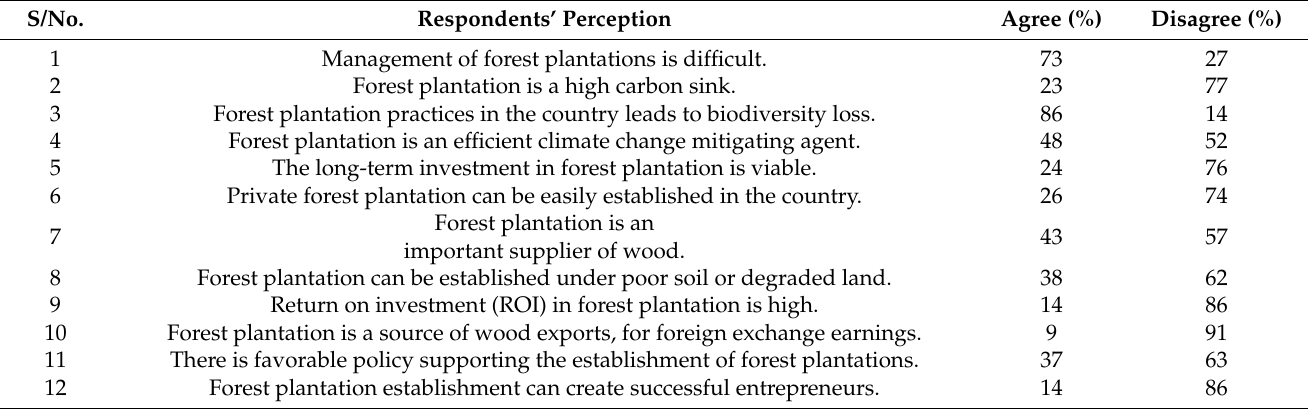
Table 4. Respondents’ Perception Towards Private Forest Plantation Establishment.